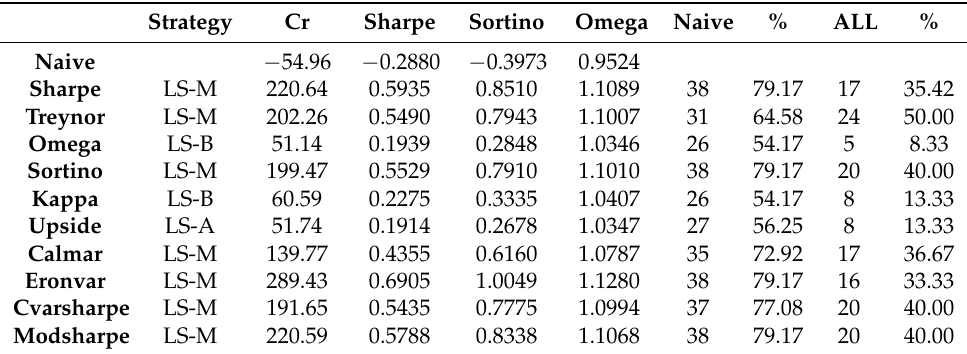
Table 4. Summary and outperformance